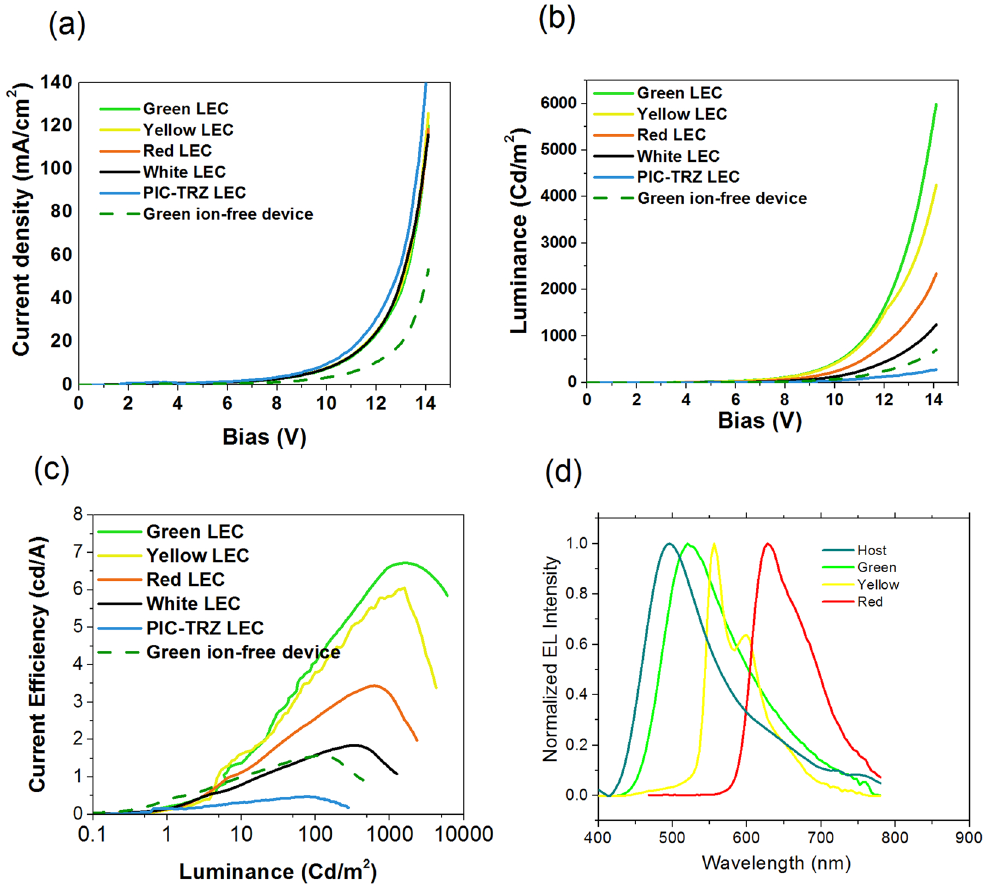
Figure 3. EL characterizations. ( a ) Current density and ( b ) luminance at different applied potential; ( b ) current efficiency at different luminance; ( d ) EL spectra for different